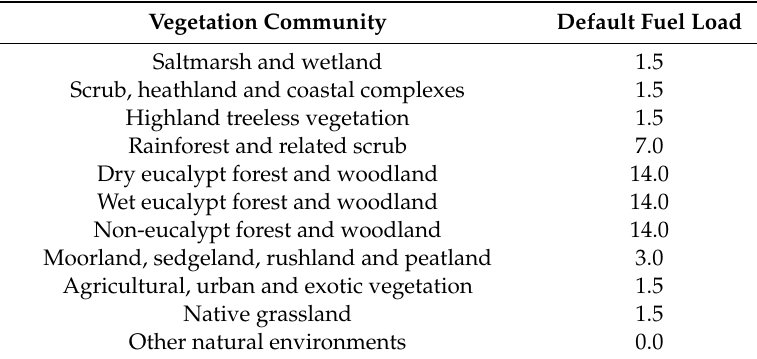
Table 3. Default fuel load in vegetation community.